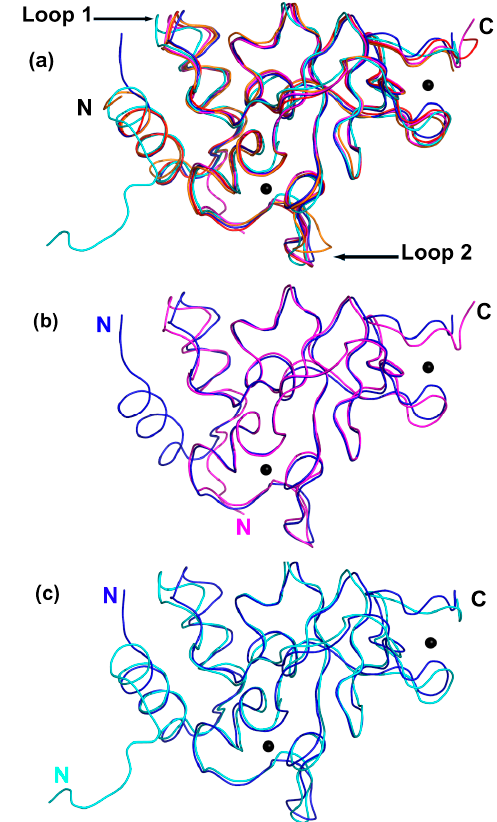
Figure 3. Structural overlays of unbound nsp10 (this work) compared to bound nsp10 from SARS, MERS and SARS-CoV-2. ( a ) Overlay of SARS-CoV-2 nsp10 (blue), SARS-CoV-2 nsp10–nsp16 complex (magenta, PDB ID 6w75), unbound SARS nsp10 (red, PDB ID 2fyg), SARS nsp10–nsp14 complex (cyan, PDB ID 5c8u) and MERS nsp10–nsp16 (orange, PDB ID 5yn5). Zn ions are shown as grey spheres. Variable Loops 1 and 2 are indicated by black arrows. ( b ) Overlay of nsp10 (blue) and nsp10 from nsp10–nsp16 complex from SARS-CoV-2 (magenta; PDB ID 6w75). ( c ) Overlay of nsp10 (blue) and nsp10 from nsp10–nsp14 complex from SARS (cyan; PDB ID 5c8u).